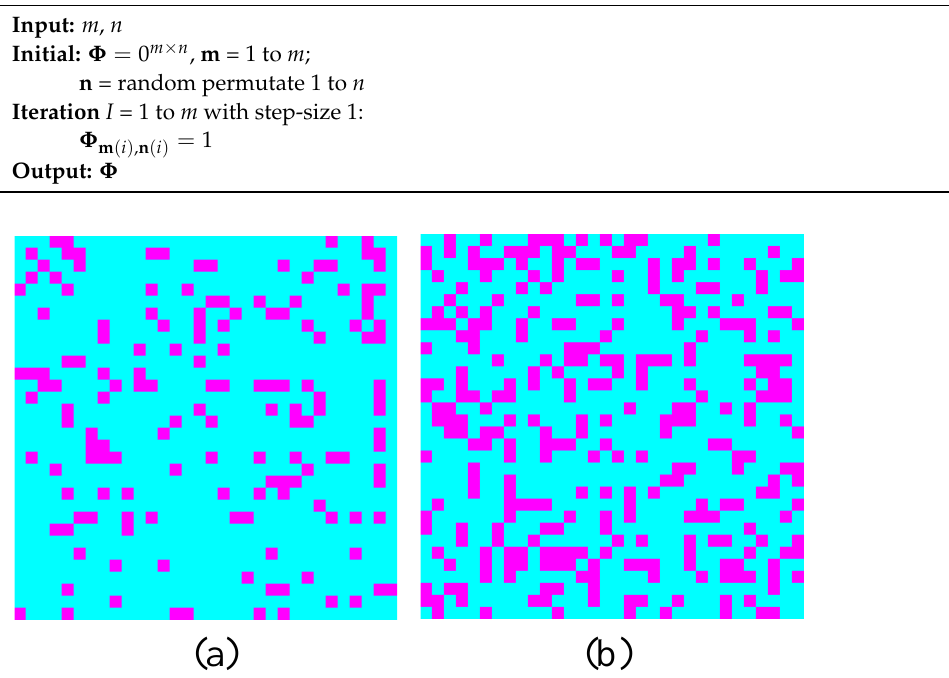
Algorithm 1. Measurement matrix for NRI systems.